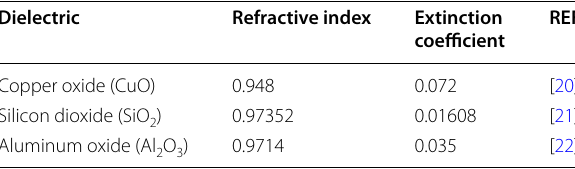
Table 1 FDTD parameters at wavelength of 13.5